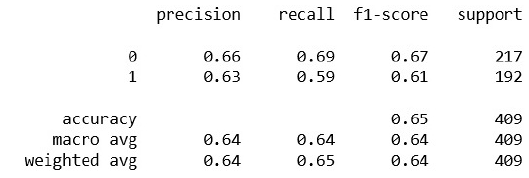
Figure 12. Classification report for the SVC-based